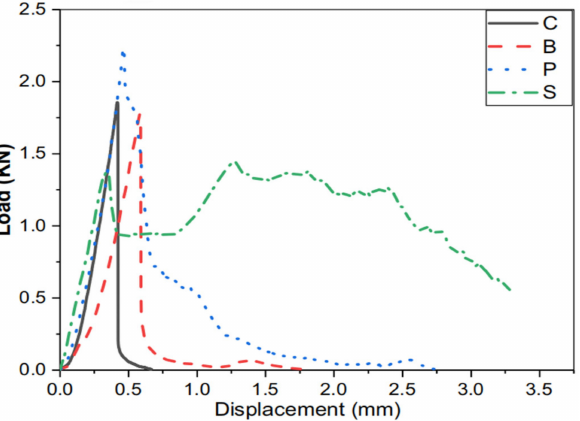
Figure 3. Load displacement curves under flexural loading. PVA fibers (P), basalt fibers (B), micro- steel fibers (S) and control (C: no fibers). Adapted with permission from [66], copyright 2020 Elsevier.